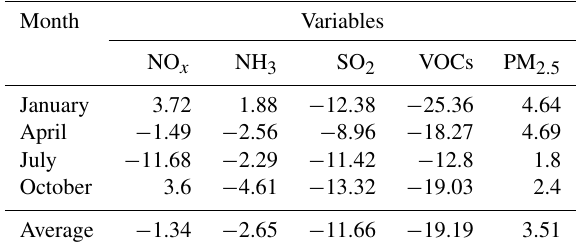
Table 2. Change ratios of N-Emis compared with P-Emis for the 4 months (given as a